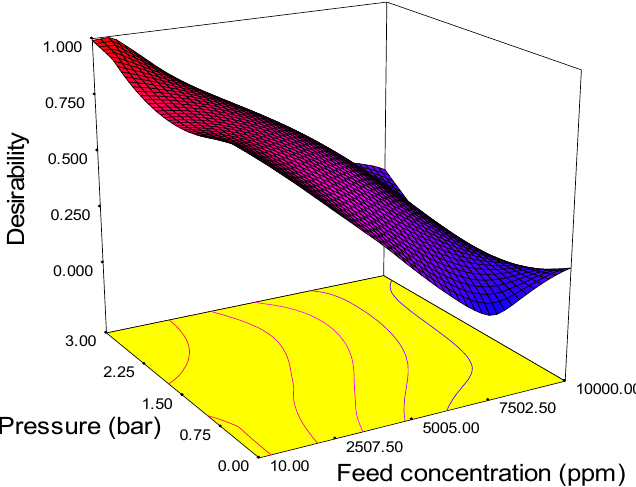
Figure 9. 3D surface graph and contour plot on desirability based on the interaction effect of pressure and feed concentration.